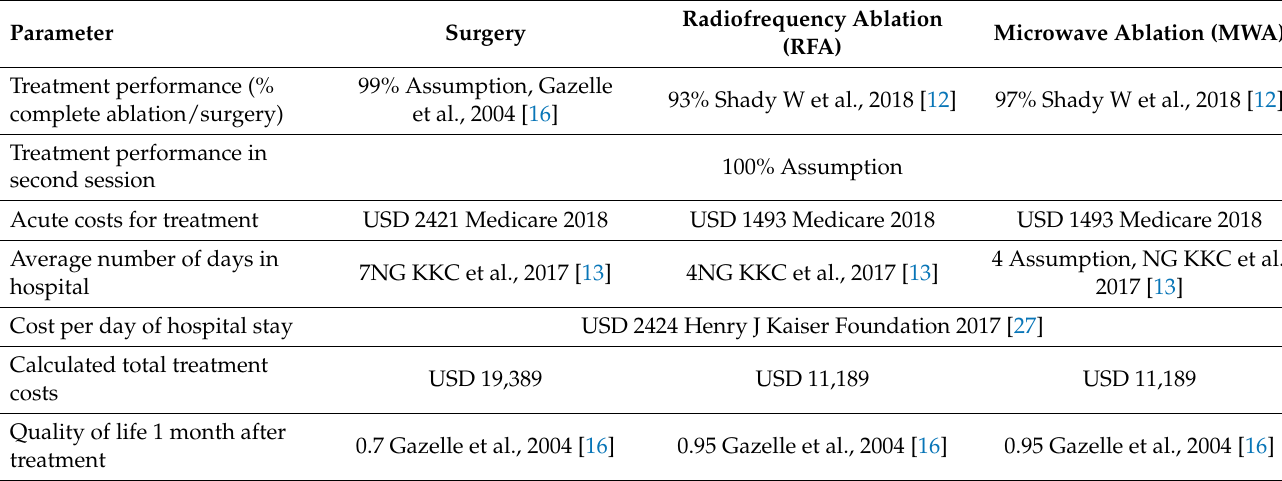
Table 1. Input parameters for treatment performance, costs and quality of life for all treatment modalities.